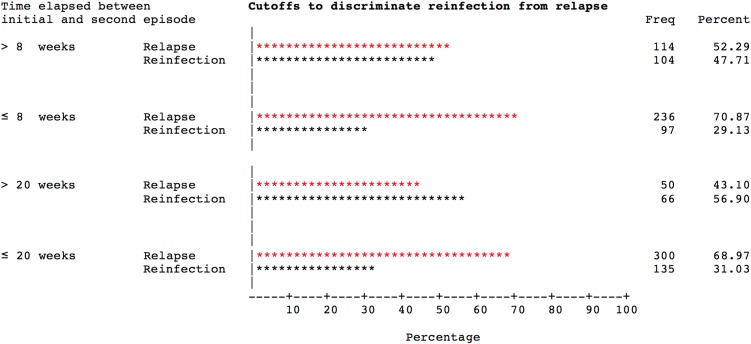
Performance of the 8- and the 20-week cut-off intervals in separating reinfections from relapses. (Reinfections) occurred within the 8- and 20-weeks intervals. Relapses occurred outside the 8- and the 20-weeks intervals.